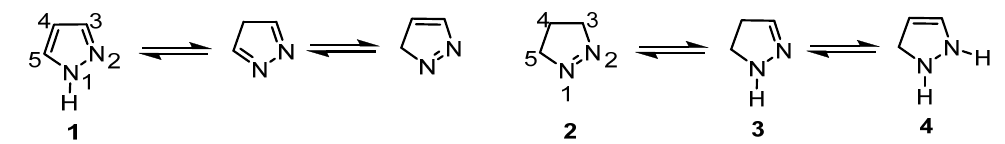
Figure 1. Chemical structures and numbering of pyrazole ( 1 ) and dihydropyrazole (pyrazoline) tautomers 2 – 4 [18].